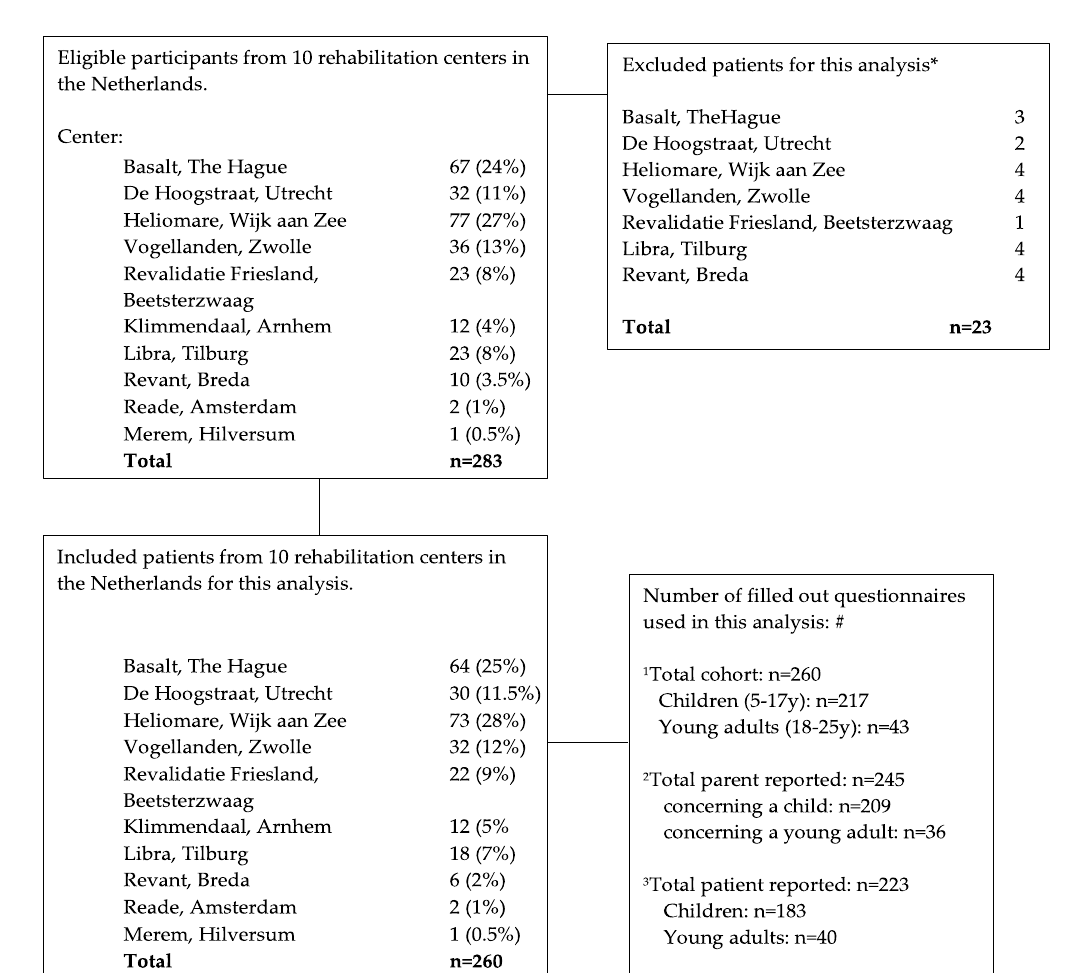
Figure 1. Flow of children and young adults with ABI admitted for rehabilitation and eligible for the present analysis. * Missing participants: n = 11 no official ABI diagnosis, n = 12 incomplete questionnaires. # Number of filled out questionnaires used in this analysis (total/patient-reported/parent-reported): 1 ; number of questionnaires filled out by the patient, the parents or both in total and per age group (children, adolescents and young adults). 2 ; number of questionnaires filled out by parents only in total and per age group (children, adolescents and young adults). 3 ; number of questionnaires filled out by patients only (self-reported) in total and per age group (children, adolescents and young adults).